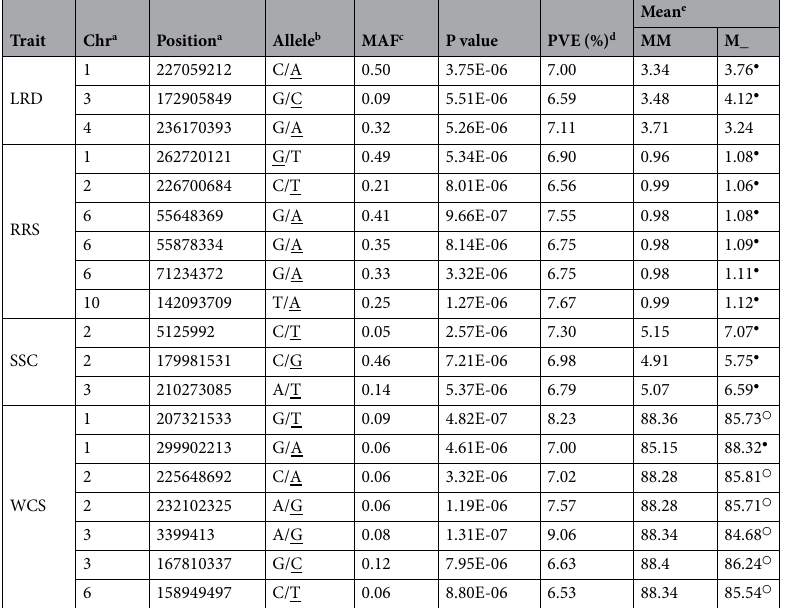
Table 2. Significant loci for the four chilling tolerance traits identified by GWAS across the testcrosses. a Loci revealed by GWAS. b The minor alleles are underlined, and the Mo17 alleles are on the left of the slash sign; c MAF = minor allele frequency; d PVE = phenotypic variation explained by the locus; e Means of the four traits in different genotypes at the significant loci; MM denotes the homozygous Mo17 alleles, and M_ is heterozygous. • Heterozygous alleles at the significant loci had positive effects compaired to homozygous alleles; ○ Heterozygous and homozygous alleles had similar